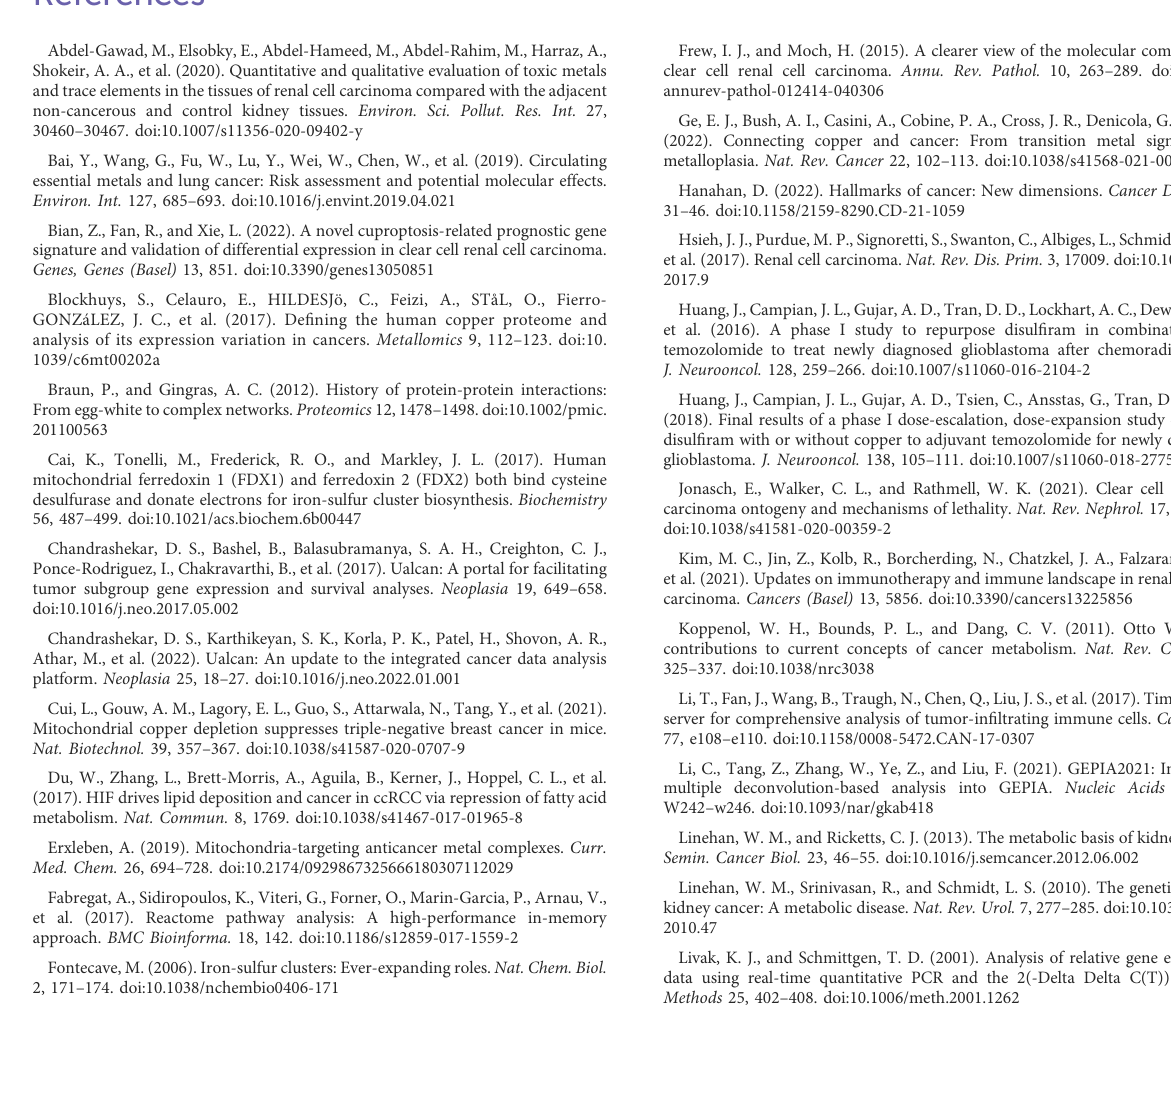
SUPPLEMENTARY FIGURE S1 FDX1 mRNA and protein expression across cancer cell lines. SUPPLEMENTARY FIGURE S2 The functional enrichment networks of FDX1 co-expressed genes involved in the BP, CC, and